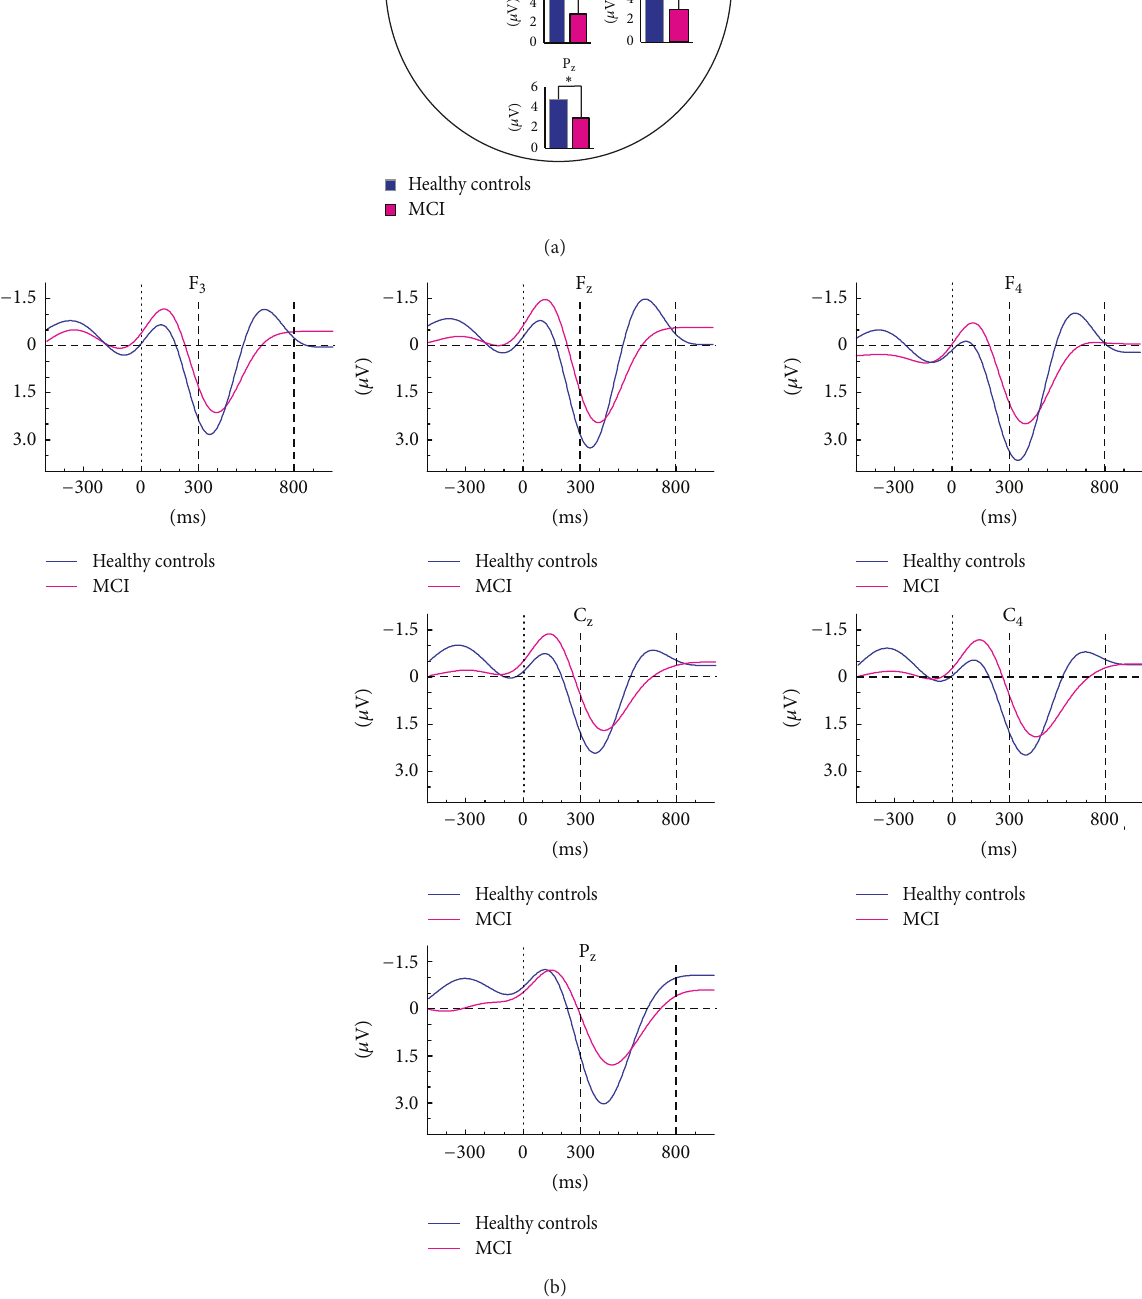
Figure 2: Histograms and grand averages of oscillatory delta (0.5–2.2 Hz) responses. (a) Histograms of mean grand averages of F 3 , F z , F 4 , C z , C 4 , and P z electrode sites in delta (0.5–2.2 Hz) frequency range for 300–800 msec poststimulus. “ ∗ ” represents significant results with 𝑃 < 0.05 and “ ∗∗ ” represents significant results with 𝑃 < 0.01 . (b) Grand averages of delta (0.5–2.2 Hz) oscillatory responses of healthy controls ( 𝑛 = 21 ) and mild cognitive impairment (MCI) subjects ( 𝑛 = 22